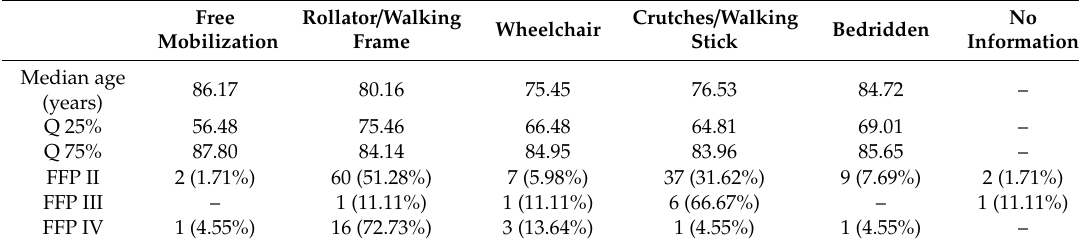
Table 2. Mobilization at time of discharge.